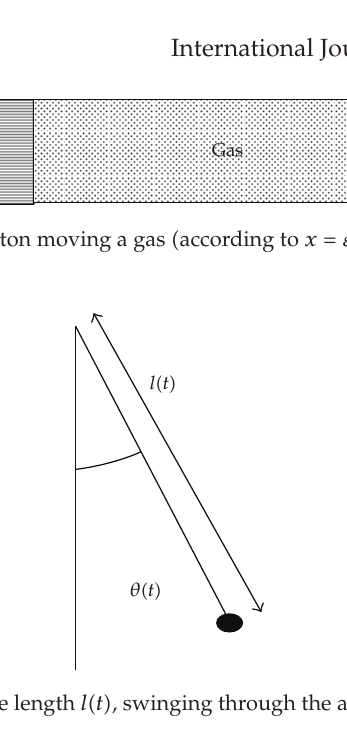
Figure 2: Pendulum of variable length l (cid:4) t (cid:5) , swinging through the angle θ (cid:4) t (cid:5) (cid:4) in a vertical plane (cid:5)